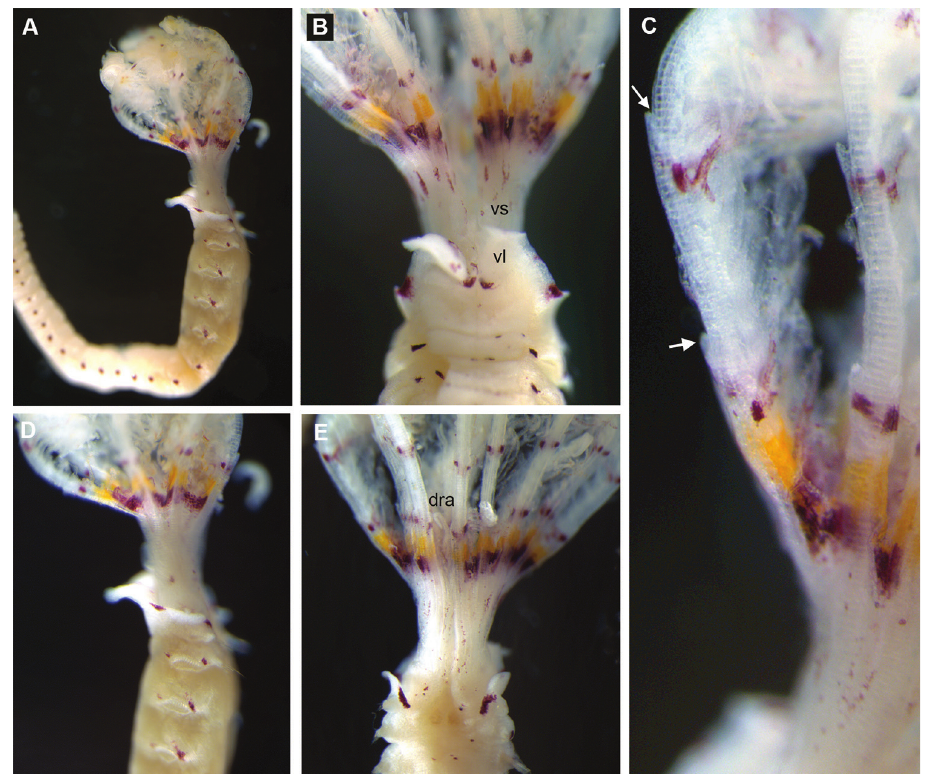
Figure 8. Pseudobranchiomma cf. P. schizogenica . AM W.36368, AM W.36369. Photographs. A Ante- rior end, lateral view B Detail of base of crown and anterior segments, ventral view C Detail of lateral radiole D Anterior thoracic segments, lateral view E Anterior thoracic segments, dorsal view F Anterior thoracic segments, dorsal view. dra, dorsal radiolar appendages; vl, ventral lappet; vs, ventral sac; white arrows, serrations of radiolar lateral